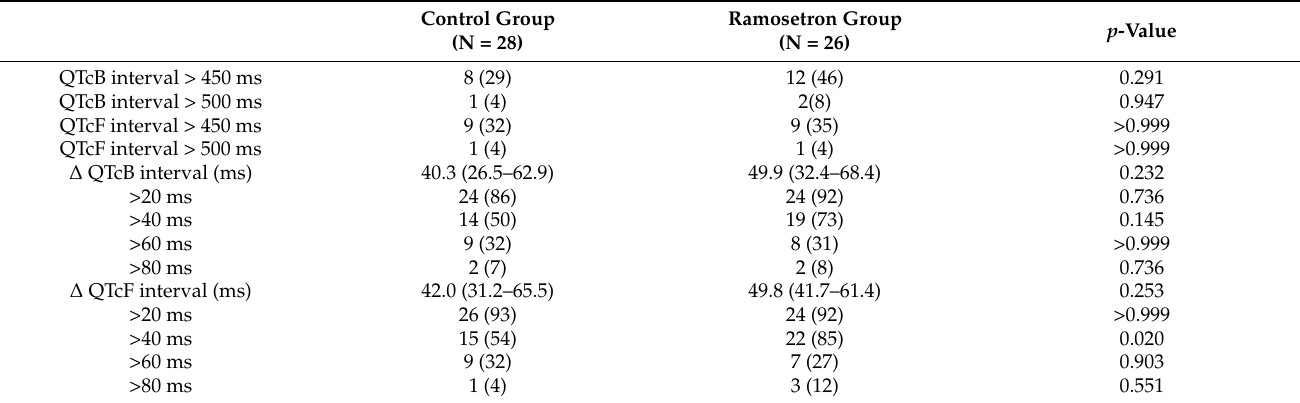
Table 2. Changes in QTc interval during robot-assisted laparoscopic prostatectomy. Control Group (N = 28)